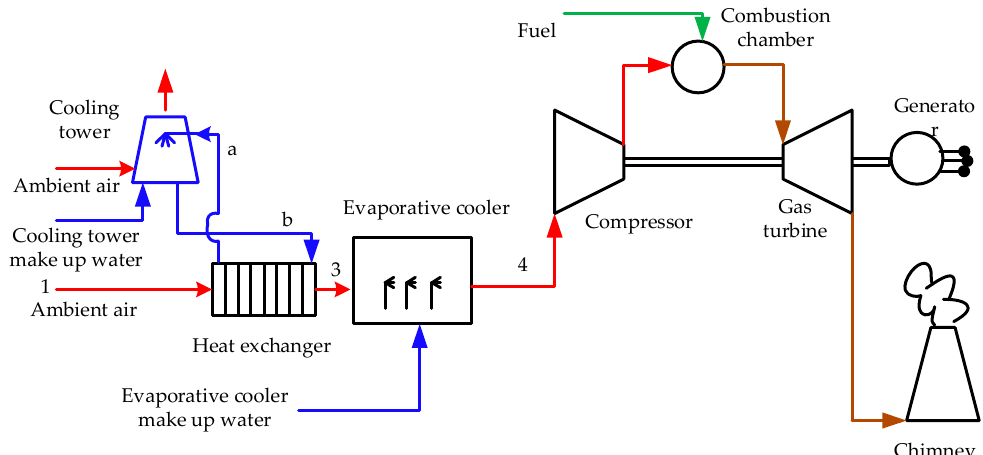
Figure 3. Gas turbine with two-stage evaporative inlet cooling.